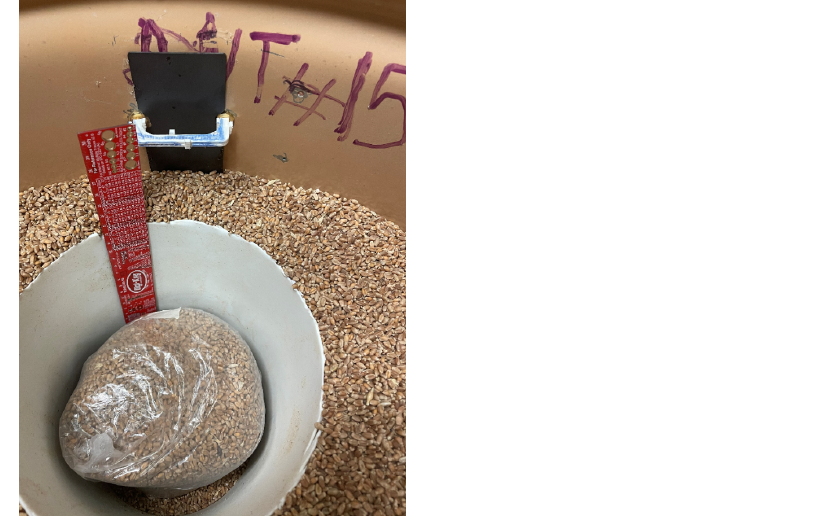
Figure 8. Target close to FLA 15 while it is in the bucket before covering with